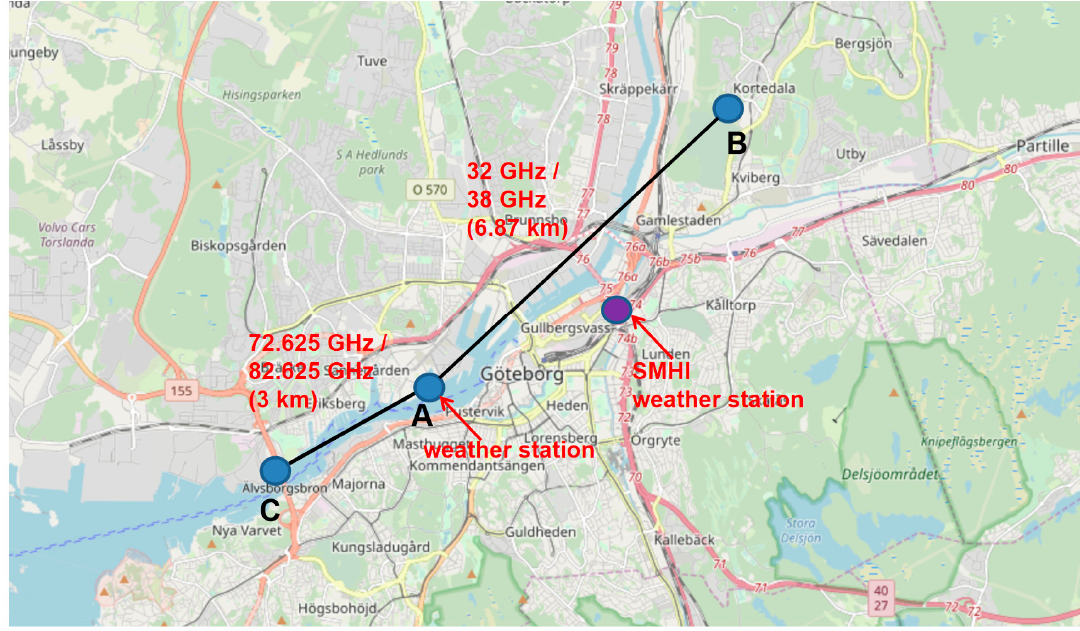
Figure 3. The measurement setup and locations in Gothenburgh, Sweden. SMHI, Swedish Meteorological and Hydrological Institute. Table 3. Outdoor measurement parameters.